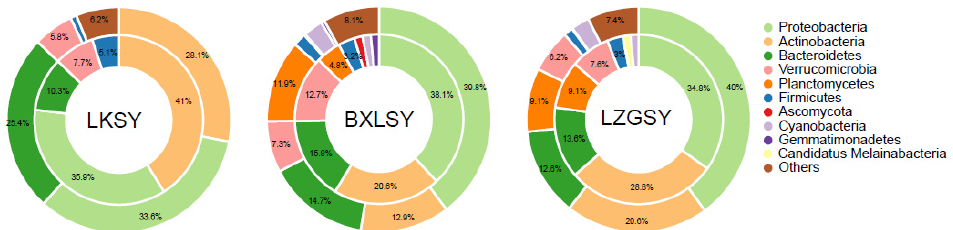
Figure 6. Attribution analysis of ARGs and bacteria phyla in all water samples showed by circle map. The distribution of bacteria phyla of the total ARGs was represented in inner circle, and the phyla distribution of all samples was in the outer circle.